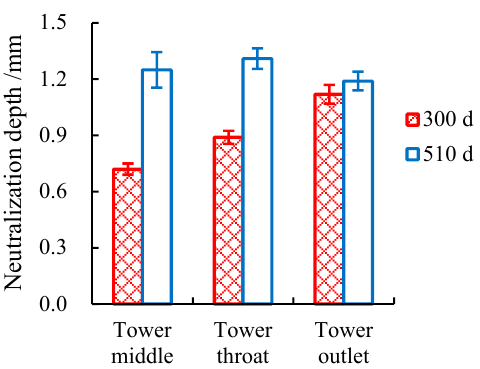
Figure 7. Neutralization depths of in situ specimens at different locations.